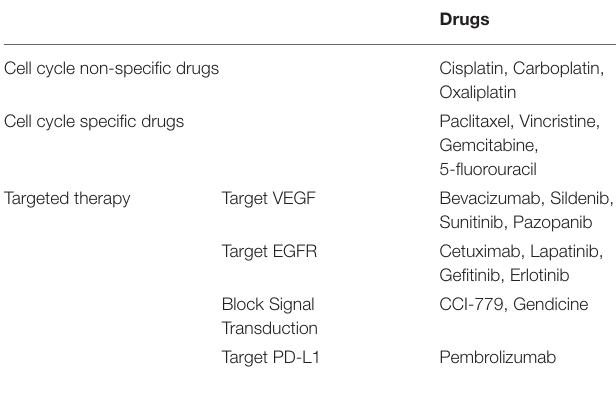
TABLE 1 | Common drugs used for cervical cancer treatment in